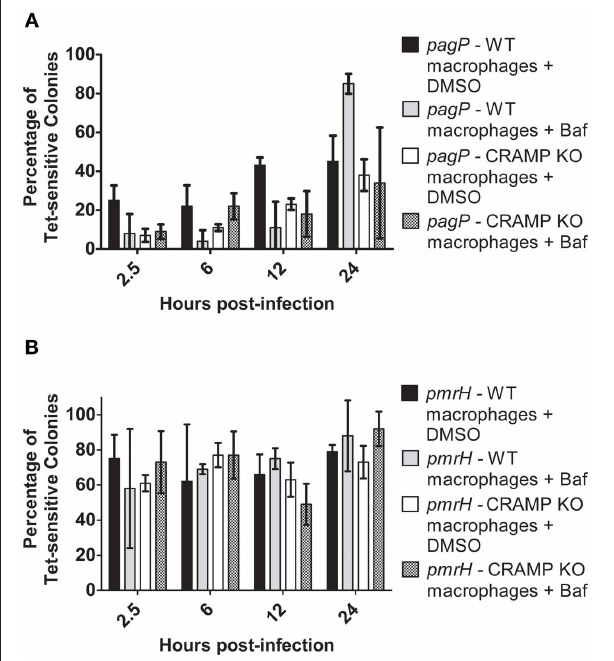
FIGURE 4 | TCRS-mediated activation of pagP and pmrH in WT and CRAMP KO macrophages. BALB/c and CRAMP-deficient mouse bone marrow-derived macrophages were infected with the S. Typhimurium (A) pagP or (B) pmrH RIVET strain. Gentamycin-treated macrophages were lysed at 2.5, 6, 12 and 24h p.i., Lysates containing intracellular bacteria were plated on LB and incubated O/N at 37 ◦ C. Resulting colonies were patched onto LB and LB Tet to detect loss of Tet-resistance due to promoter activation. Graphed values represent the mean ± standard deviation of one representative experiment performed at least twice in triplicate. ∗ Indicates p < 0 . 05.